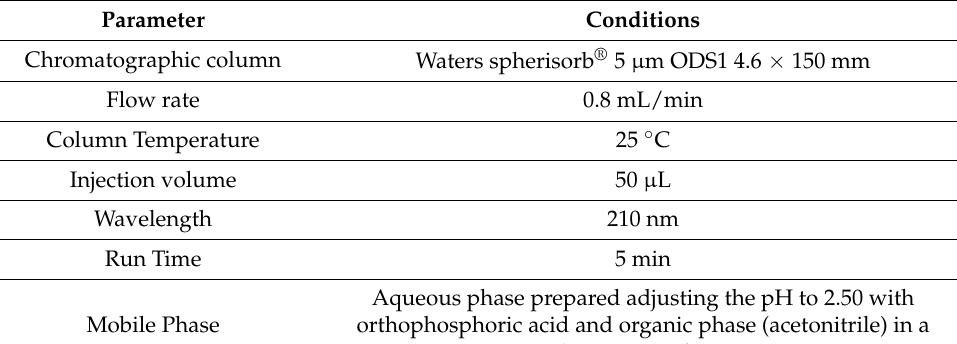
Table 5. Optimized operating conditions for N-acetylcysteine (NAC) quantification in high- performance liquid chromatography